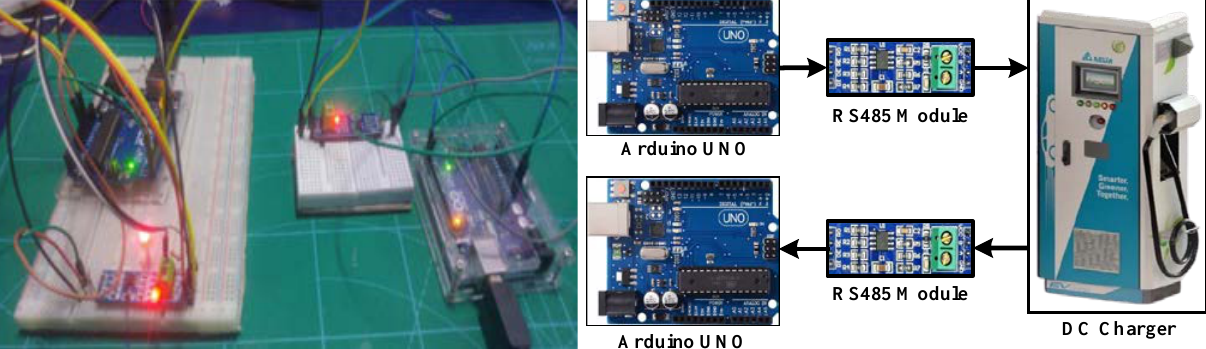
Figure 12. Arduino connections with Modbus.